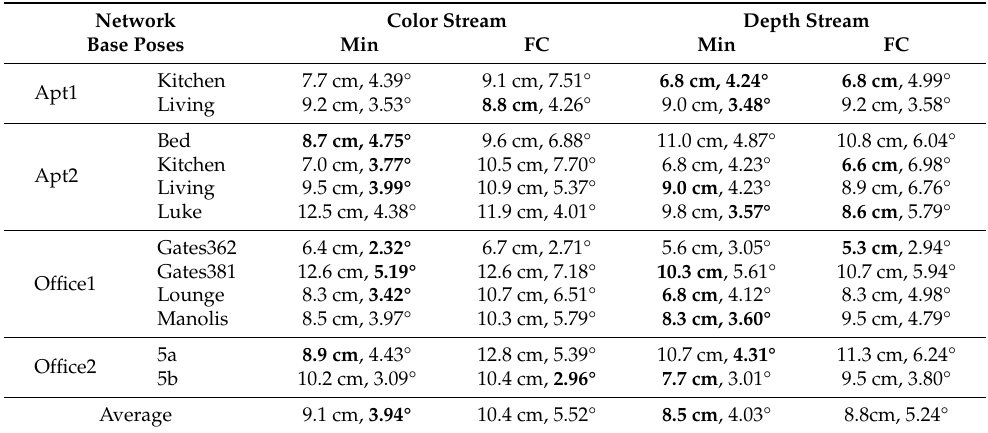
Table 7. Median translation error (cm) and rotation error (°) for single streams with different base poses on 12 Scenes . Bold numbers indicate the lowest error value.